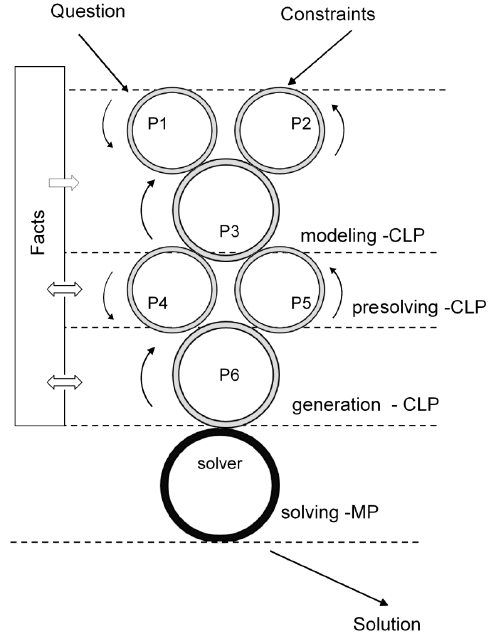
Fig. 2. The schema of declarative programming framework for modeling and solving scheduling problems.